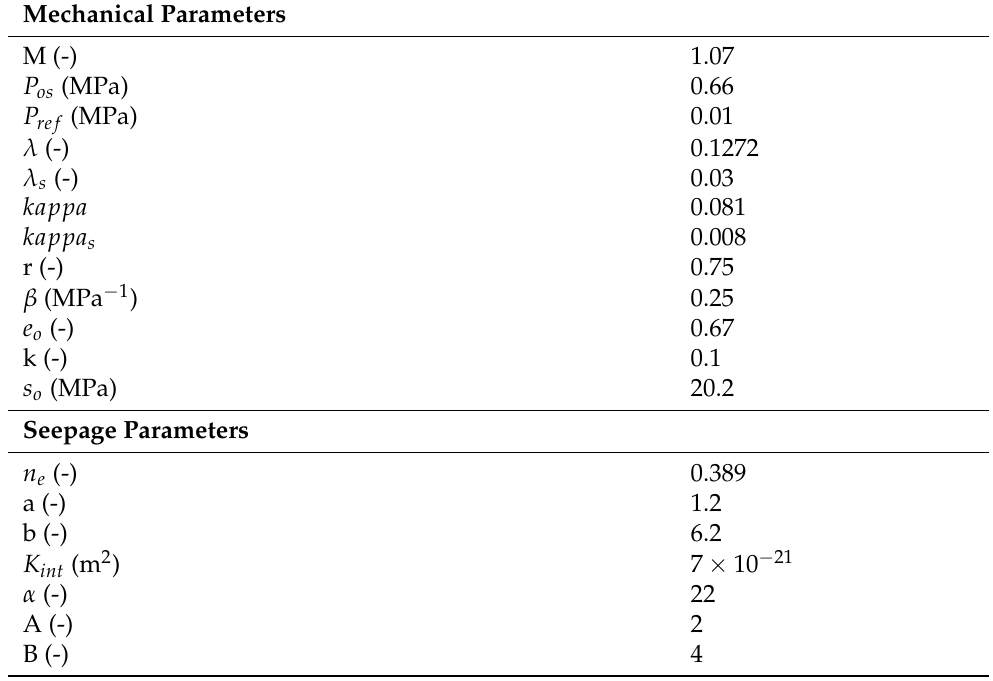
Figure 5. Numerical modeling approach of SO-02–04 in suction controlled compression. Table 2. Numerical parameters for hydromechanical modeling of bentonite/sand